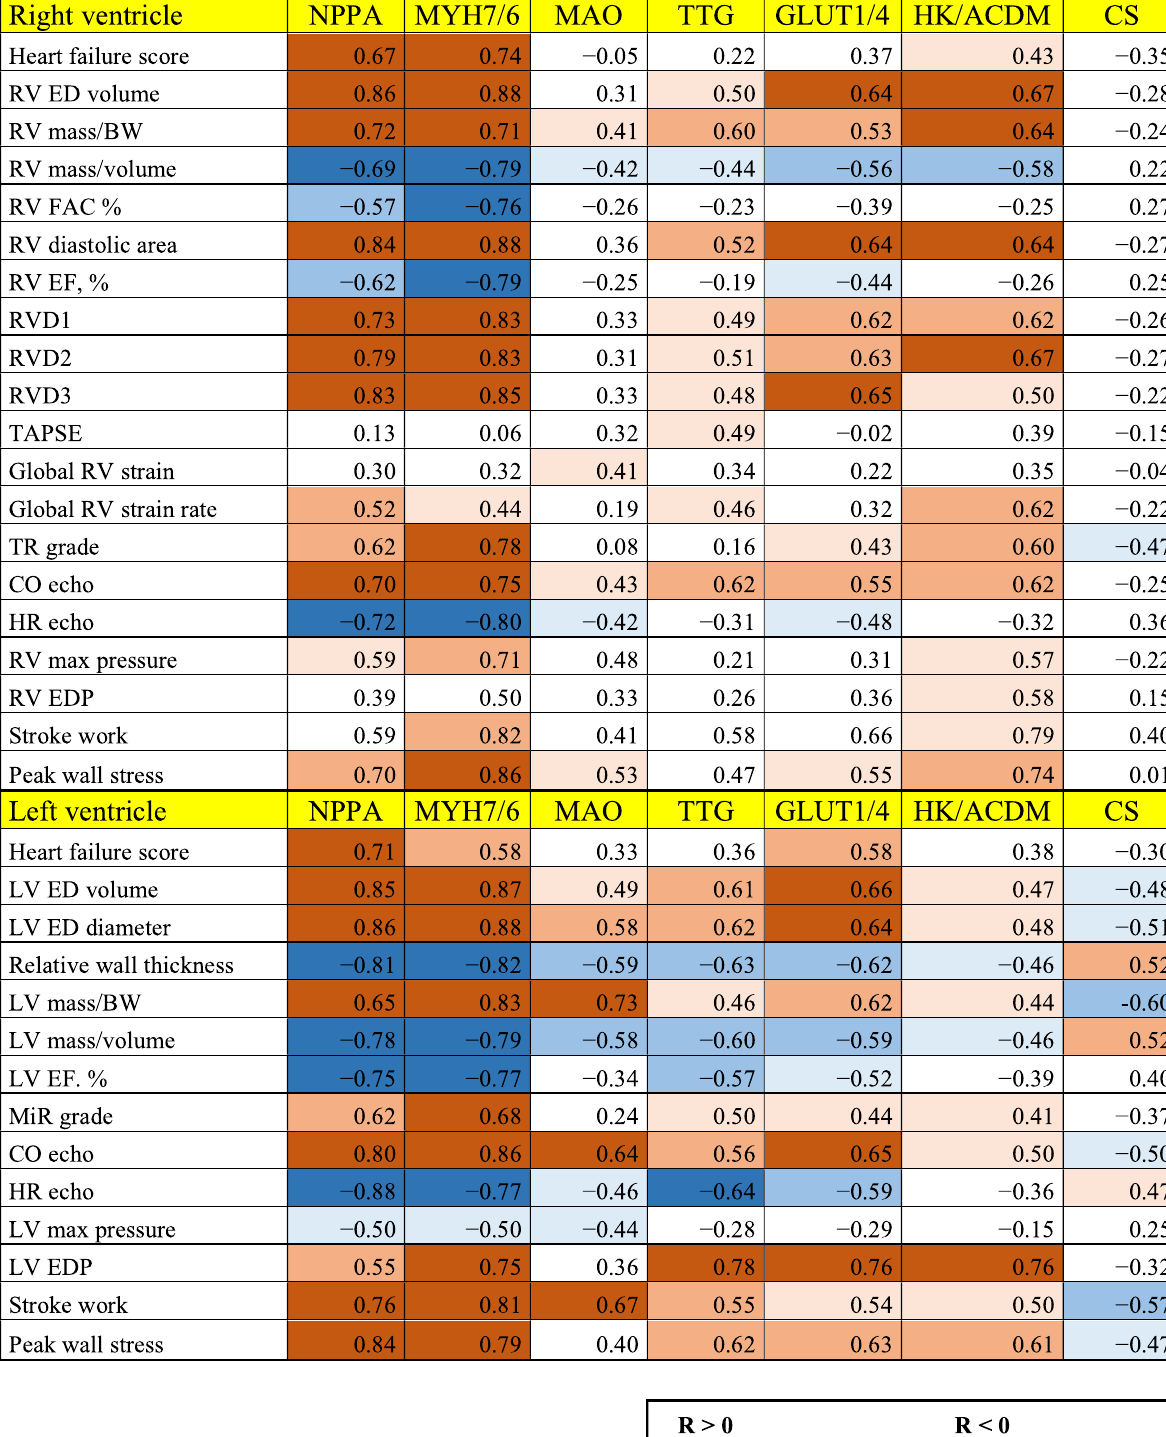
Table 3. Correlation matrix of cardiac function parameters and gene expression in aggregated dataset. Values are Pearson’s r. p values are coded by colors. RV, right ventricle; ED, end-diastolic; BW, body weight; FAC%, fractional area change; RVD, right ventricular diameter; TR, tricuspid regurgitation grade; CO, cardiac output; EDP, enddiastolic pressure; MiR, mitral regurgitation; LV, left ventricle; EF, ejection fraction. For other abbreviations: see